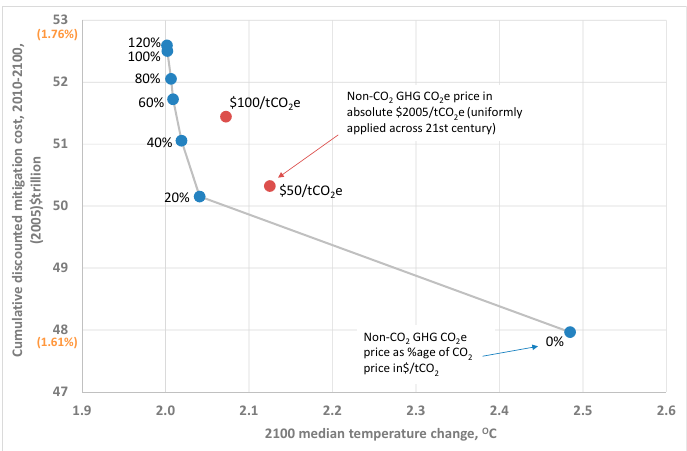
Figure 7. Cost of meeting 2100 temperature change levels with non-CO 2 GHG mitigation at a range of CO 2 e prices relative to CO 2 mitigation, for the 2 °C scenario with delayed action to 2020. Notes: Figures in parenthesis on Y-axis show costs as a share of cumulative 2000–2100 discounted GDP (at 5% per year discount rate); blue points on chart are for non-CO 2 GHG prices which vary over time (as a fixed fraction of CO 2 prices) whereas red points show time-invariant non-CO 2 GHG prices.